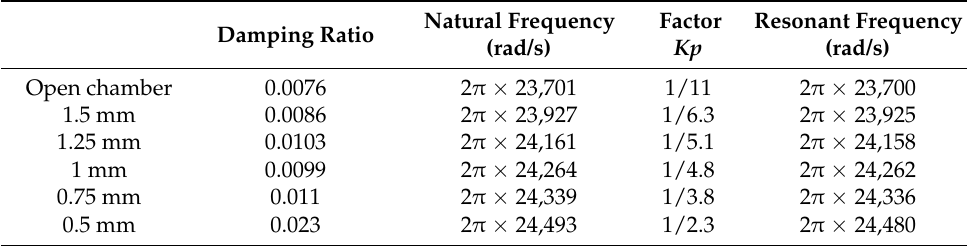
Figure 14. Relation between the normalized frequency responses P 3 fft ( s ) of measured sound pressures and fitting results of Kp ( s ) Gs ( s ) as well as the corresponding P 1 fft ( s ) for varied cavity lengths: ( a ) 1.5 mm; ( b ) 1.25 mm; ( c ) 1 mm; ( d ) 0.75 mm; ( e ) 0.5 mm. Table 3. The parameters Kp , ζ , ω n, and ω p of the investigated PMUT operated in the open-cavity condition and with Helmholtz chamber for five different volumes (cavity